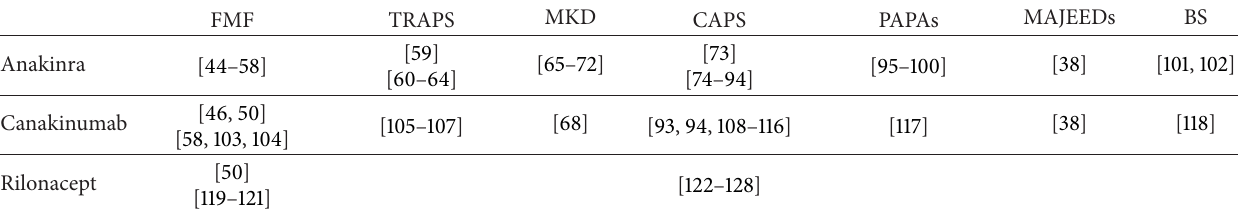
Table 2: Overview of the medical literature regarding anti-interleukin-1 therapies in the monogenic autoinflammatory disorders. FMF